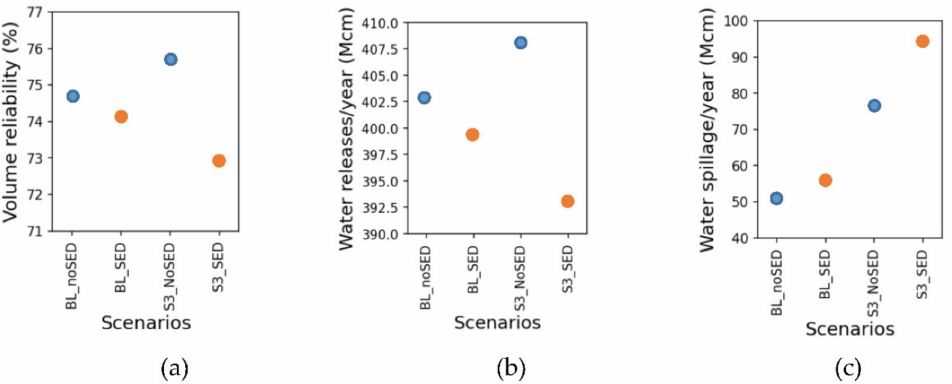
Figure 11. Assessing the reliability ( a ), water release ( b ), and water spillage ( c ) under uncertainties over 40 years using deterministic approach (the suffix:_NoSED: Sedimentation was not considered; _SED: Sedimentation was included).